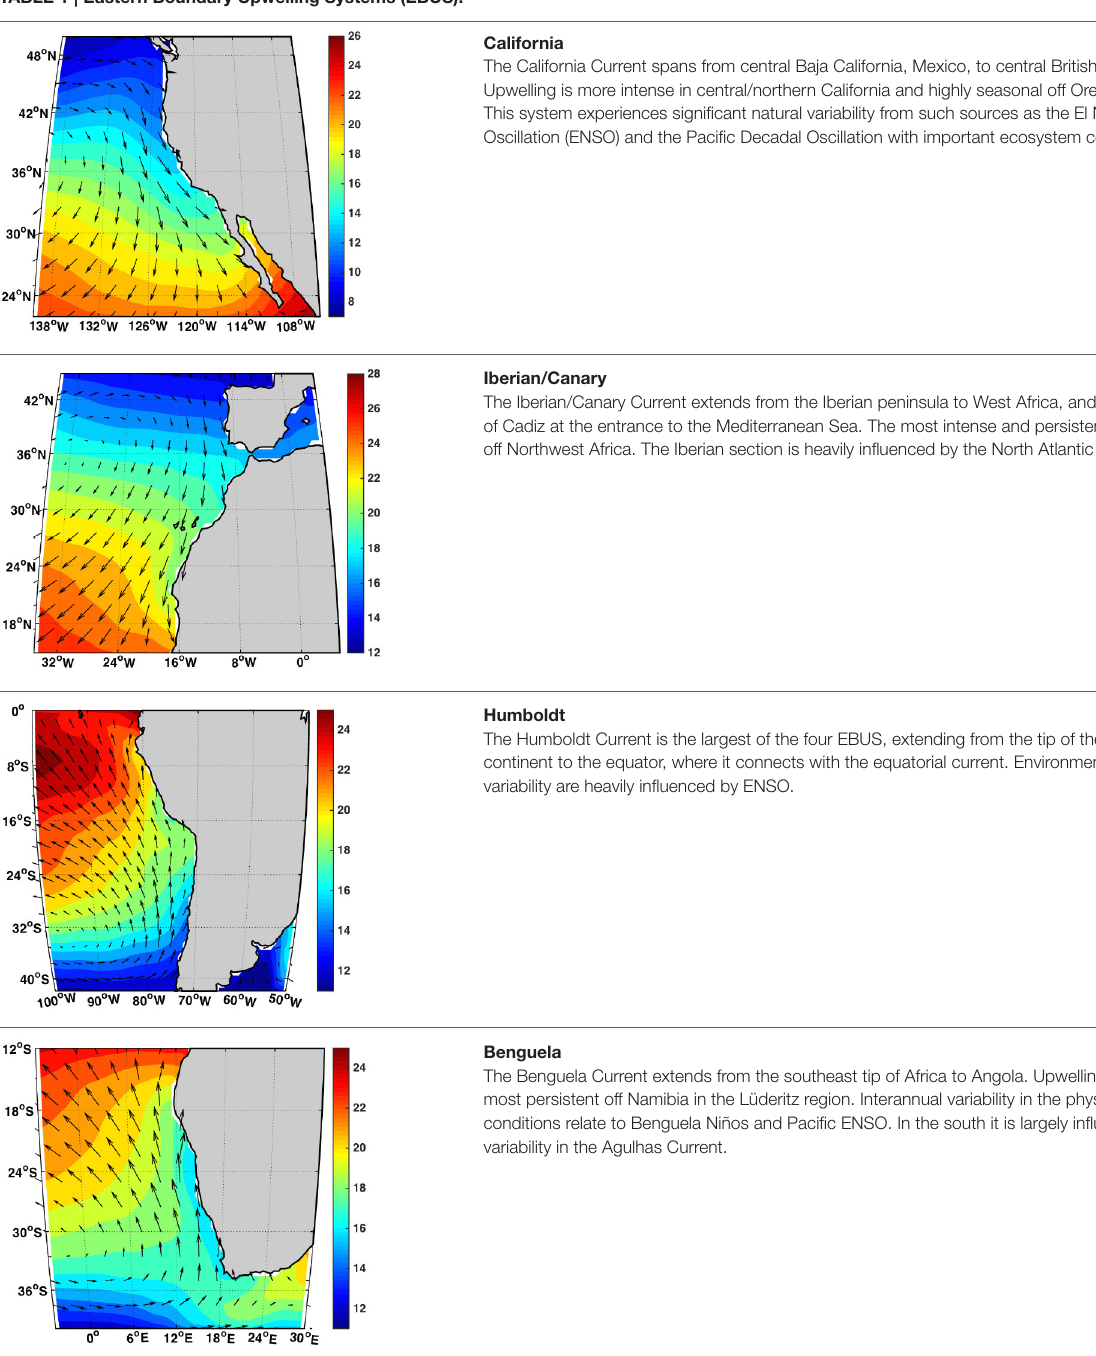
TABLE 1 | Eastern Boundary Upwelling Systems